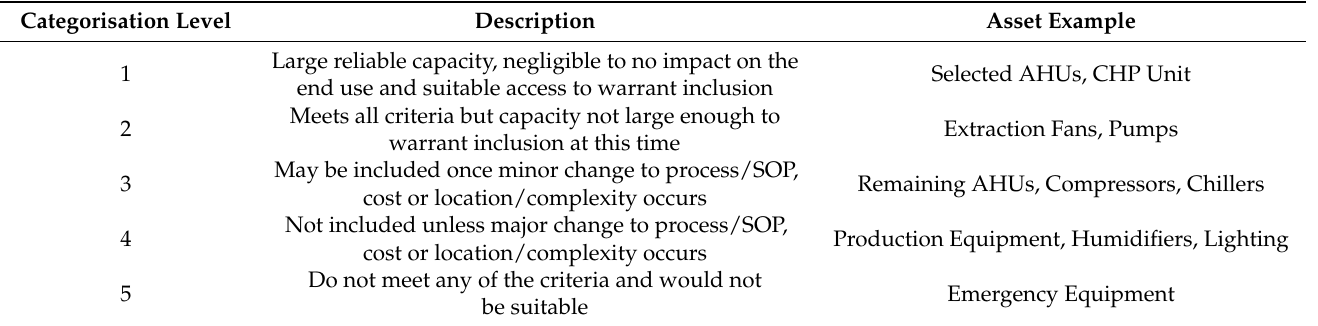
Table 5. Description of asset categorisation levels with examples from the assessment completed at the case study site. Categorisation Level Description Asset